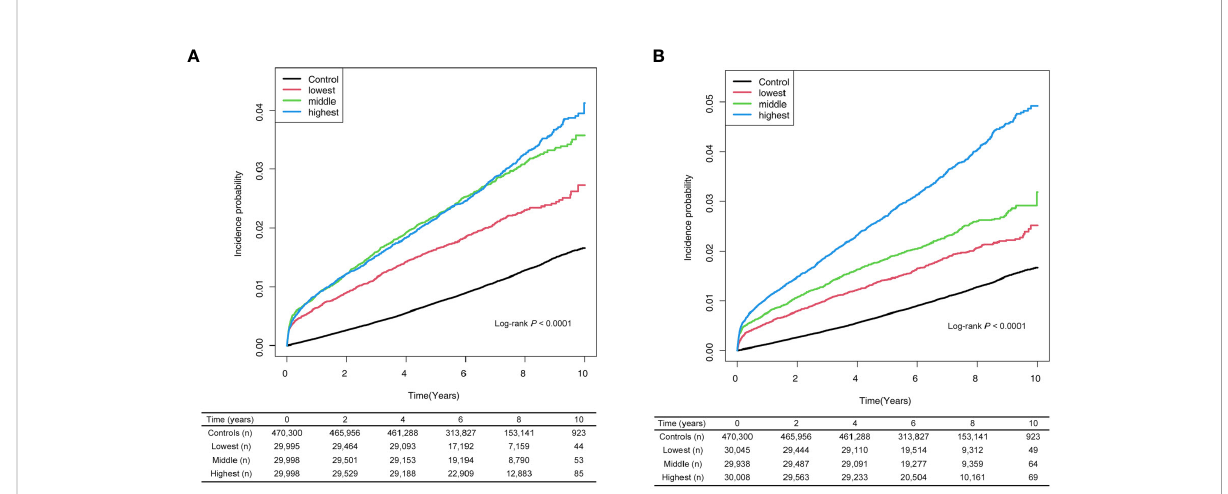
FIGURE 2 Risk of atrial fi brillation among patients with Graves ’ disease according to cumulative dose (A) and treatment duration (B) of anti-thyroid drug. Cumulative doses were <5,743 mg (lowest), 5,743 – 22,055 mg (middle), and >22,055 mg (highest). Treatment durations were <11.5 months (lowest tertile), 11.5 – 33.4 months (middle tertile), and >33.4 months (highest